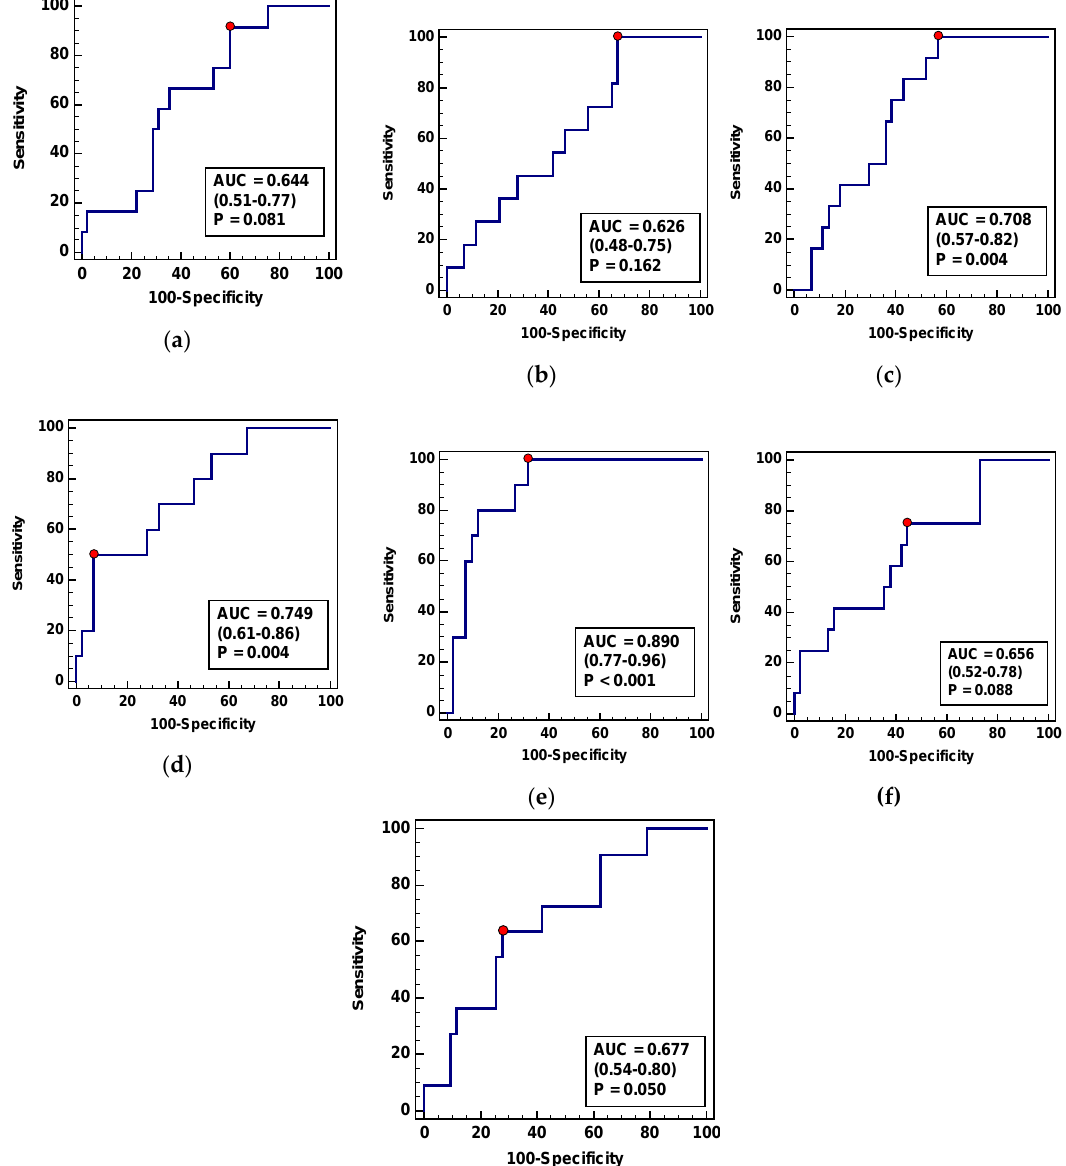
Figure 11. L-arginine/NO pathway metabolites as predictors of surgical site infections: ( a ) Arg- Δ 24/0 ; ( b ) Arg- Δ 72/0 ; ( c ) ADMA- Δ 24/8 ; ( d ) SDMA- Δ 72/24 ; ( e ) panel consisting of Arg- Δ 24/0 , Arg- Δ 72/0 , ADMA- Δ 24/8 , and SDMA- Δ 72/24 ; ( f ) Arg/ADMA- Δ 24/0 ; ( g ) Arg/ADMA- Δ 72/0 . Arg: Arginine; ADMA: Asymmetric dimethylarginine; SDMA: Symmetric dimethylarginine; AUC: Area under receiver operating characteristic (ROC) curve. Data presented as AUC with a 95% confidence interval and p- value for difference from AUC = 0.5 characterizing a chance marker. Table 12. Characteristics of L-arginine/NO pathway metabolites as predictors of surgical site infections. Marker Criterion